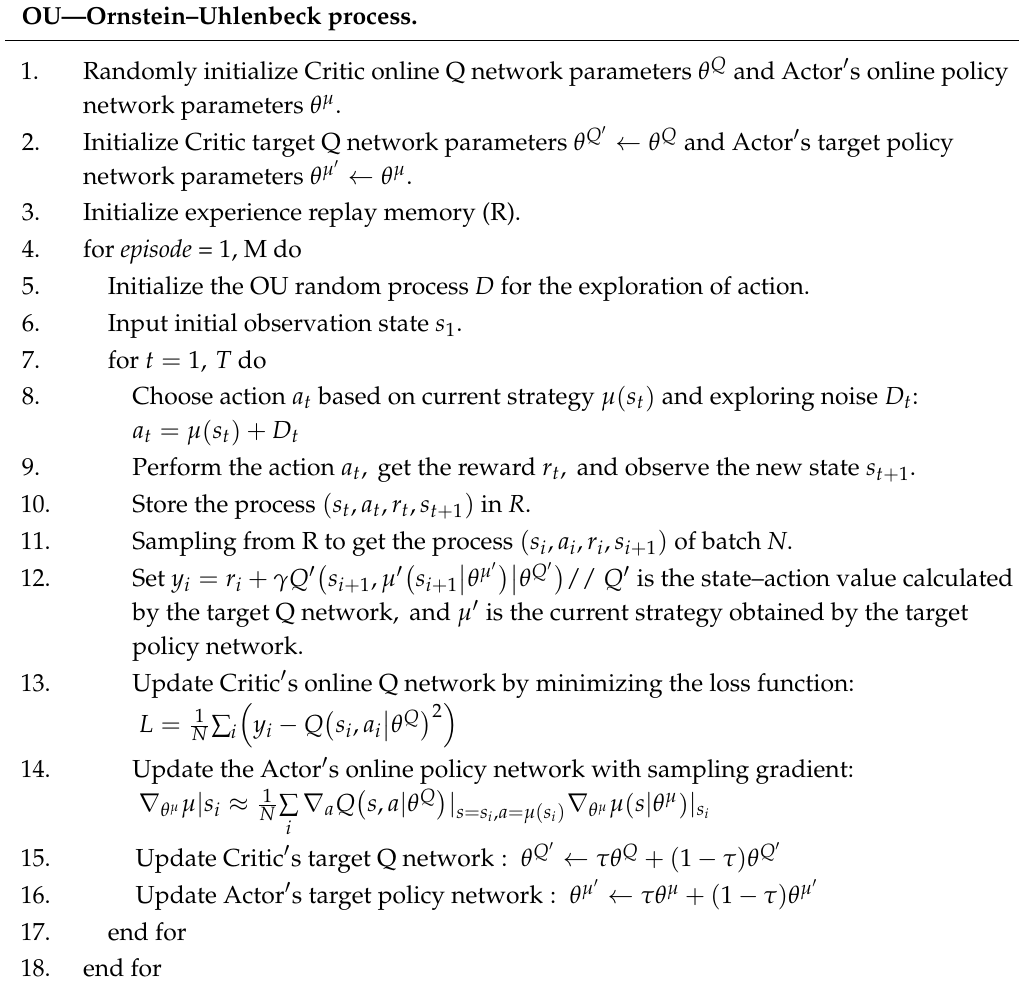
Algorithm 1. Pseudo code of the deep deterministic policy gradient (DDPG)